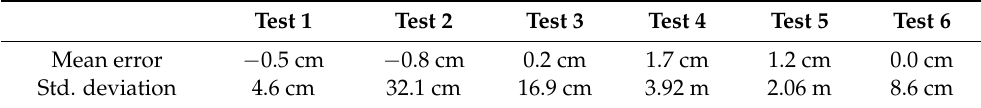
Table 3. Cloud-to-mesh distances between the mesh resulting from the “expert dataset” (used as reference) and the different scenarios testing the incorporation of crowd-sourced photographs.